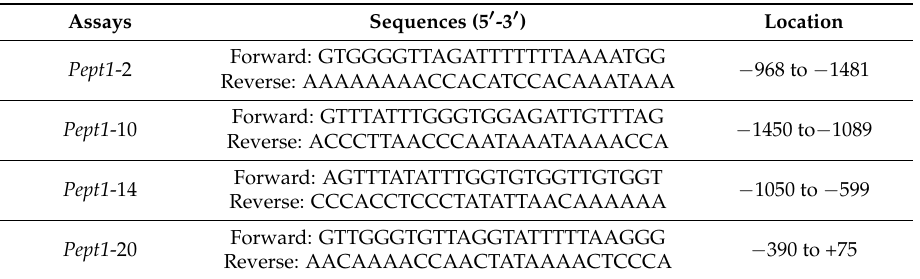
Table 3. The primer sequences and the locations relative to the translational start codon for the assays in MassARRAY-quantitative DNA methylation